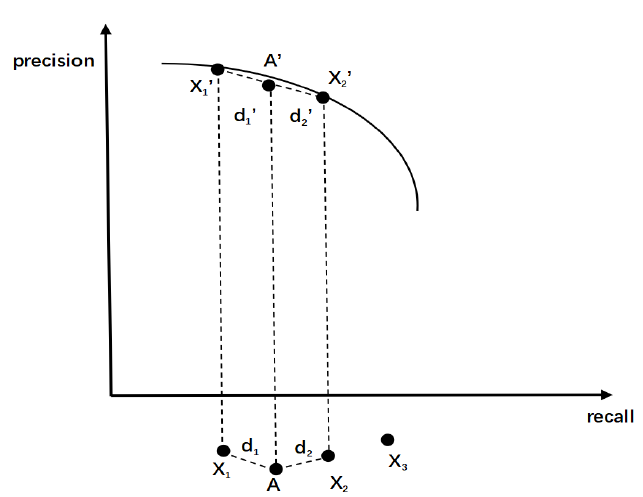
Figure 8. The interpolation